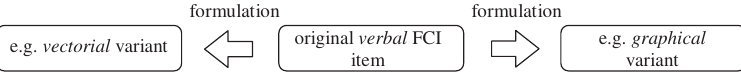
FIG. 1. A theme is a set of three isomorphic items (cid:1) differing only in their representations (cid:2) .